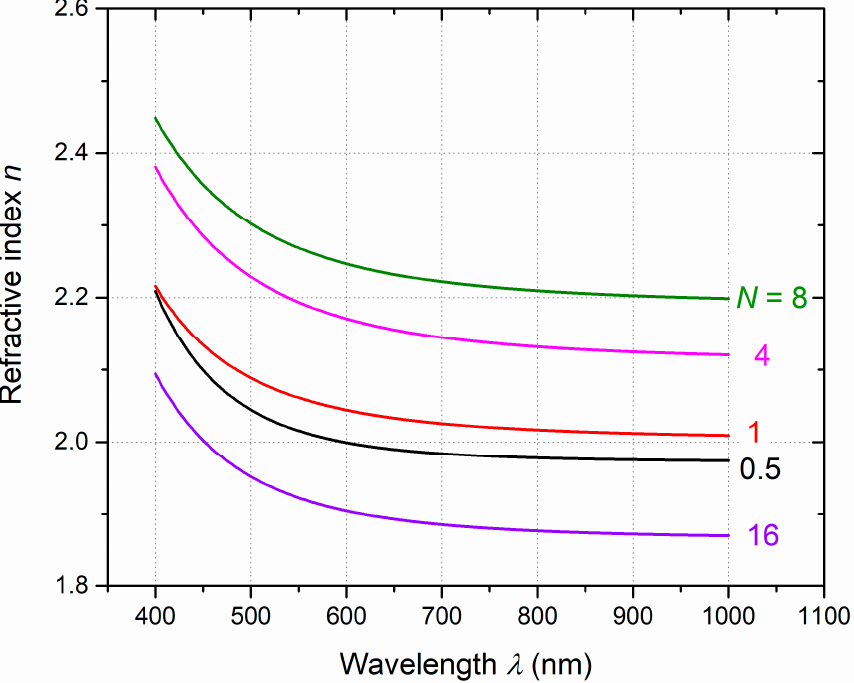
Figure 5. Refractive index as a function of the wavelength of 1 µm thick WO 3 zigzag thin films sputter-deposited on glass substrate with various numbers of zigzags ( N = 0.5 to 16). All films were obtained with a tilt angle α = 80 ◦ and a duty cycle dc = 80% of the pulsing period P